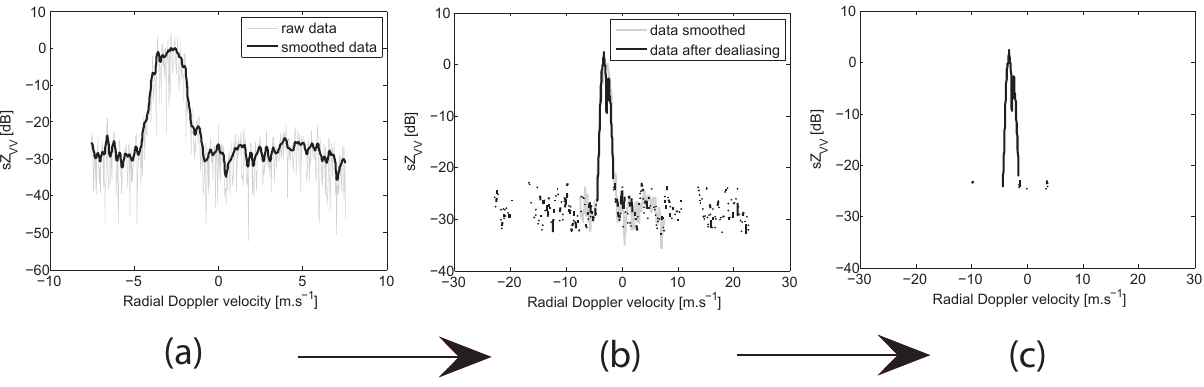
Fig. 3. TARA processing steps performed on sZ VV (v) : (a) raw data and smoothed data, (b) correction for spectral aliasing and non- simultaneous polarimetric measurements (the smoothed data from Fig. 3a is added in order to correctly see the changes performed after dealiasing) and (c) double sL DR,x clipping. After (c) , only a few noise data (dots in the spectra) are